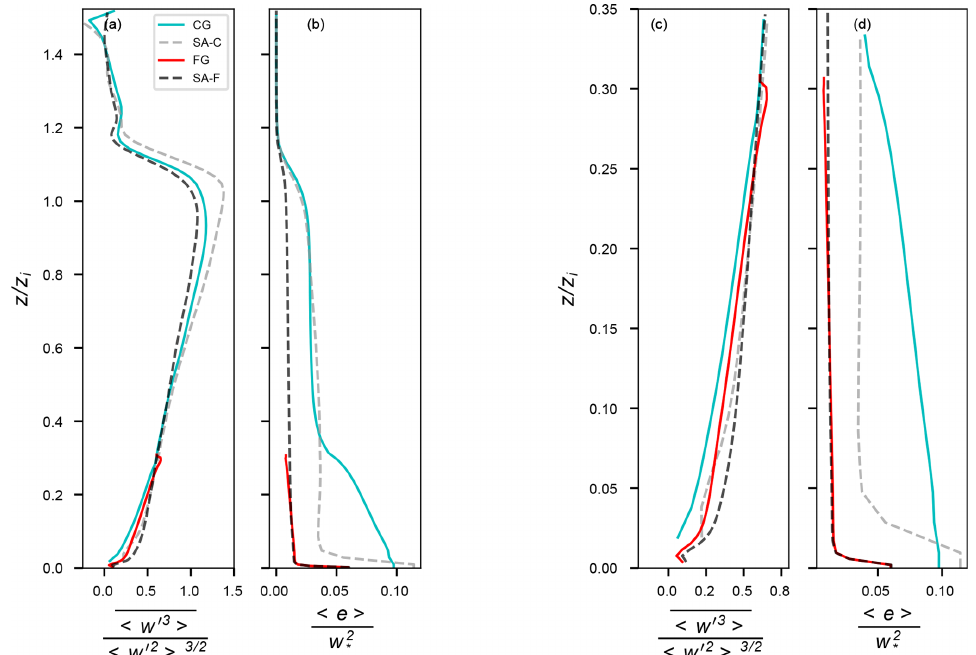
Figure 8. Vertical profile of horizontally averaged resolved vertical velocity skewness (a, c) and SGS turbulent kinetic energy e (b, d) normalized by w 2 ∗ . The SGS TKE in the CG is higher than SA-C as a result of anterpolation maintaining the Germano identity.